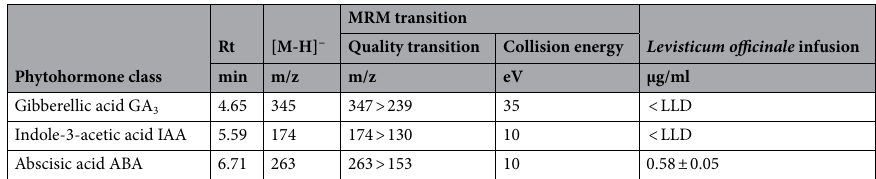
Location height of the first pod,